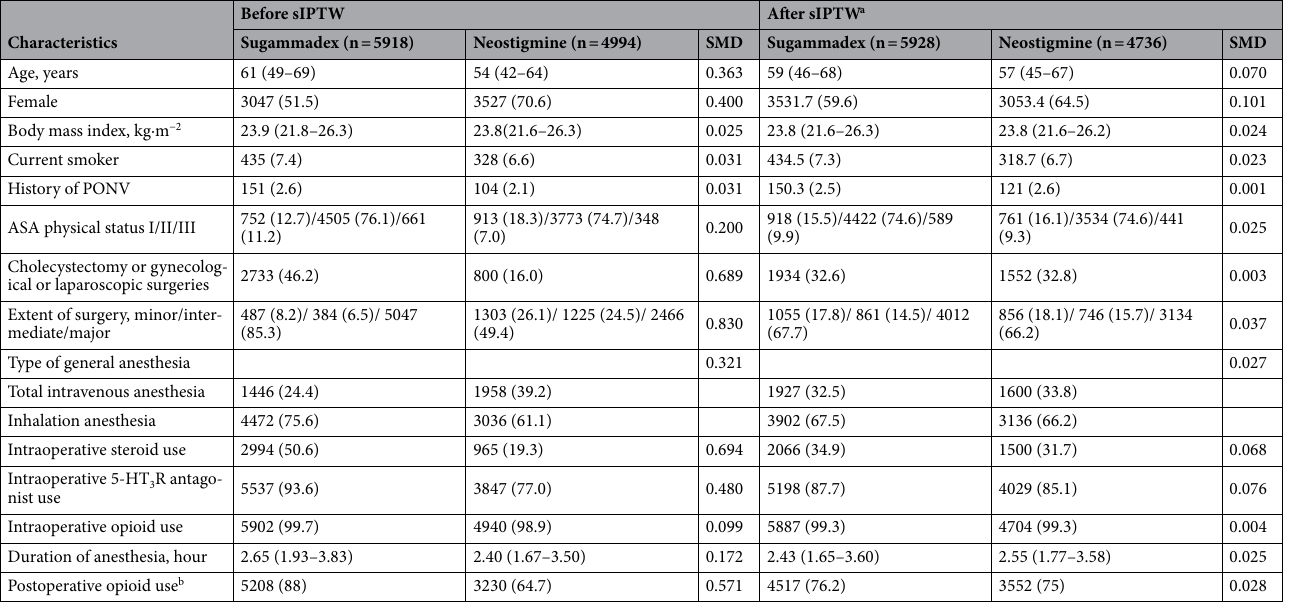
Table 1. Comparison of baseline characteristics and perioperative parameters between patients treated with sugammadex and with neostigmine before and after adjusting for confounding by sIPTW in the total cohort. The values are presented as the medians (interquartile range) or as the numbers (%). a Stabilized weights are used to adjust for confounding. The following variables are used as contributors to the propensity score: age, sex, body mass index, current smoker, ASA physical status, cholecystectomy or gynecological or laparoscopic surgeries, type of general anesthesia, intraoperative steroid use, intraoperative 5-HT 3 R antagonist use, intraoperative opioid use, and duration of anesthesia. Postoperative opioid use is not used for propensity score calculation. b During the first 24 h postoperatively. ASA, American Society of Anesthesiologists; SMD, standardized mean difference; sIPTW, stabilized inverse probability of treatment weighting; 5-HT 3 R, 5-hydroxytryptamine receptor.